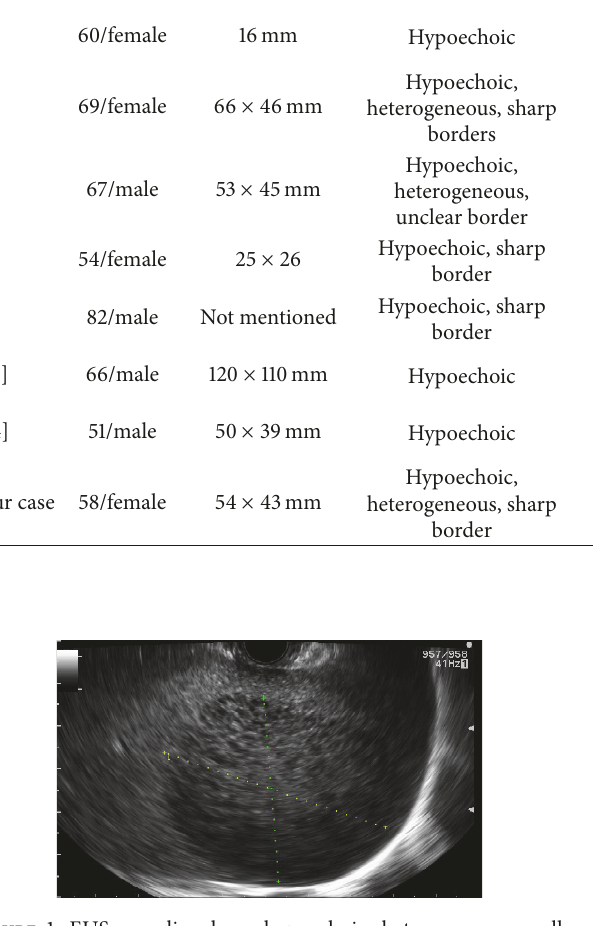
Figure 1: EUS revealing large hypoechoic, heterogeneous, well- demarcated mass measuring 54.7 mm × 43.0